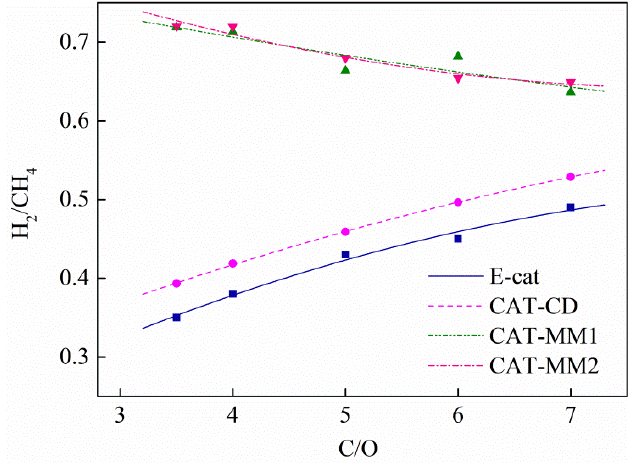
Figure 7. Hydrogen factor (H 2 /CH 4 ratio) as a function of the catalyst-to-oil ratio for different catalysts.